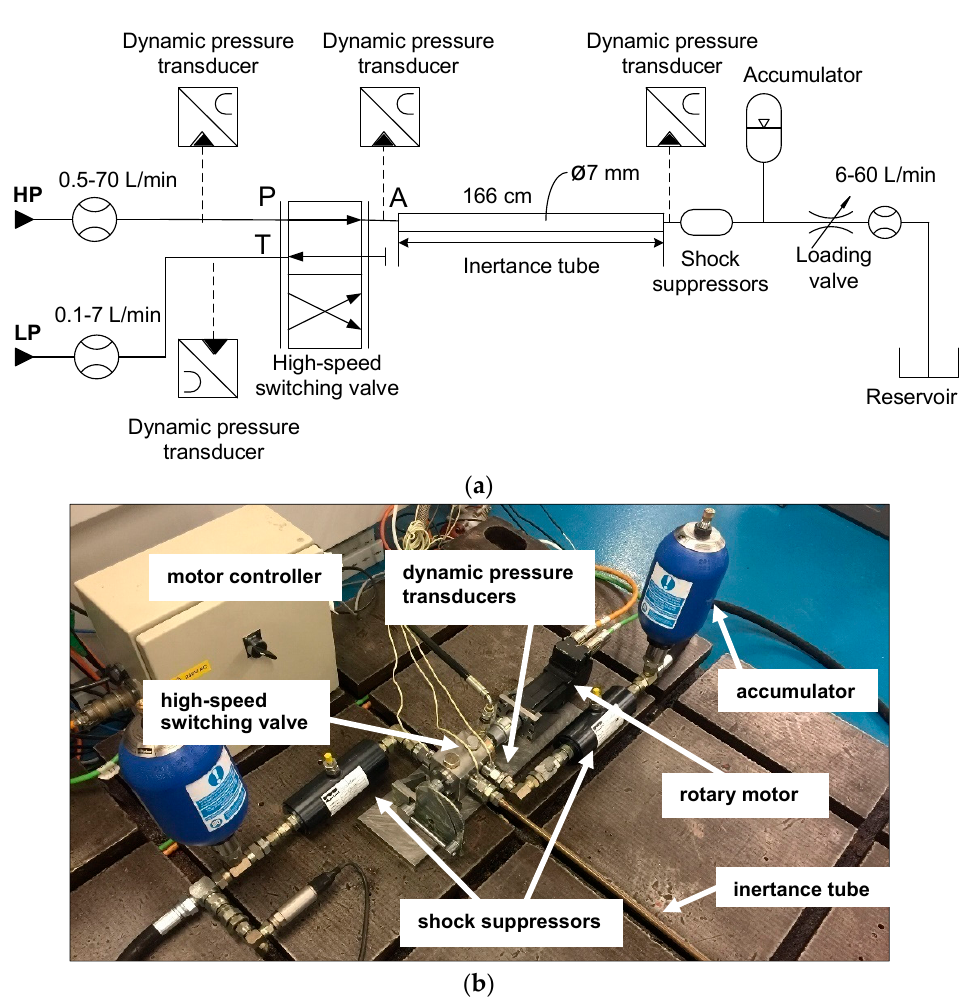
Figure 3. Test-rig ( a ) schematic and ( b ) photograph.